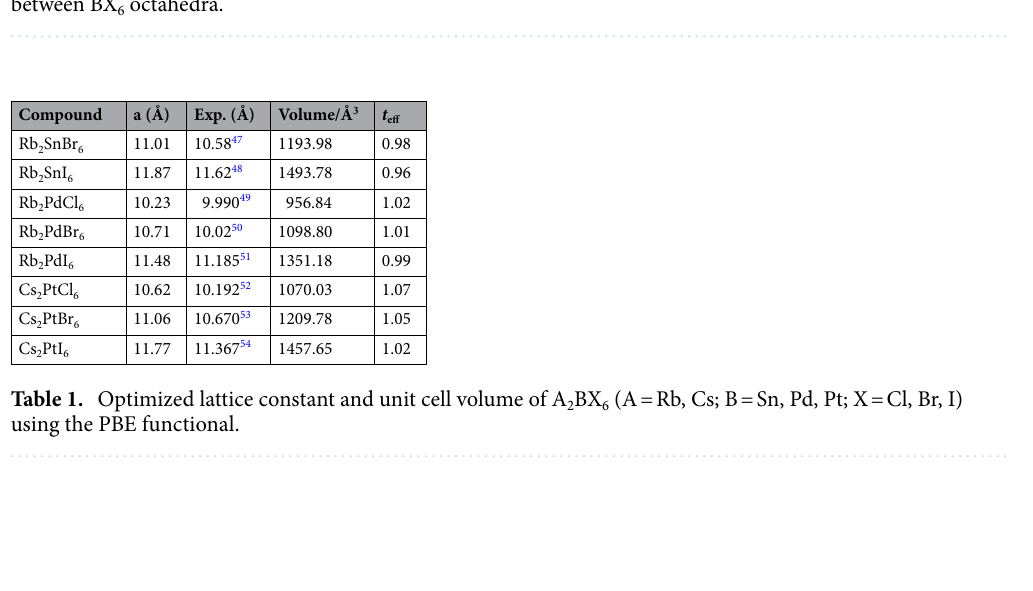
Figure 1. Schematic crystal structures of A 2 BX 6 compounds in cubic Fm3m (Left) and reorientation of the unit cell (right). The BX 6 octahedra are shaded, with the X-atom on the corners. The A-cations are in the hole between BX 6 octahedra.